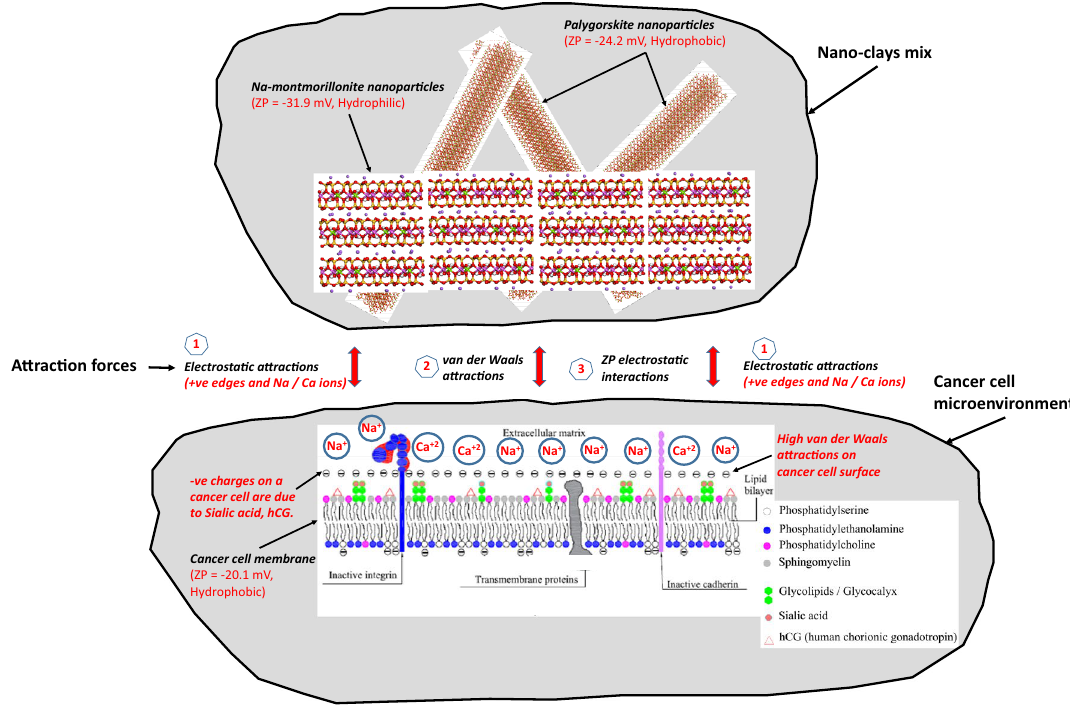
Figure 7. Three possible mechanisms of interactions of montmorillonite-palygorskite mixed clays with the cancer cells: (1) electrostatic attraction among positively charged nanoparticle edges and Na/Ca/Mg ions with negatively charged protein surfaces, (2) van der Waals attractions, (3) ZP electrostatic